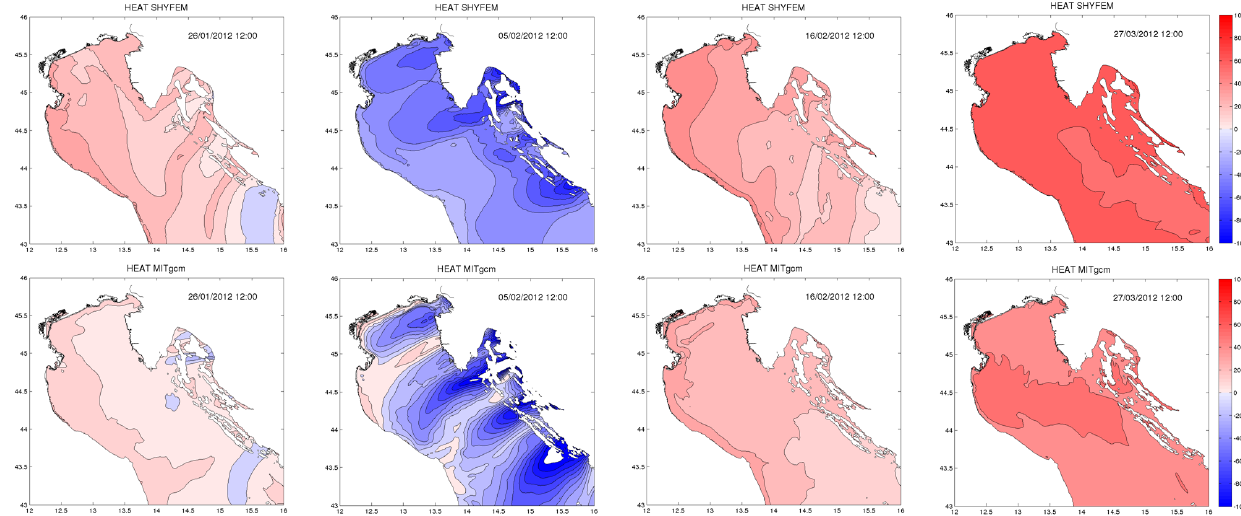
Figure 10. Maps of surface net heat flux for SHYFEM (top) and MITgcm (bottom) for the dates indicated. Units are [Wm − 2 ].